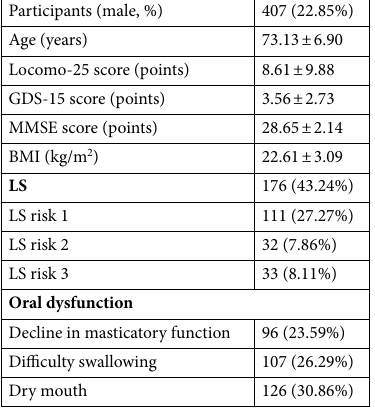
Table 1. Characteristics of the study participants. Values are presented as means (standard deviation) or prevalence (%). LS risk 1, Locomo 25 total score of 7–15 points; LS risk 2, 16–23 points; LS risk 3, 24 points or more. GDS-15 geriatric depression scale; MMSE Mini-Mental State Examination; BMI body mass index; LS locomotive syndrome.